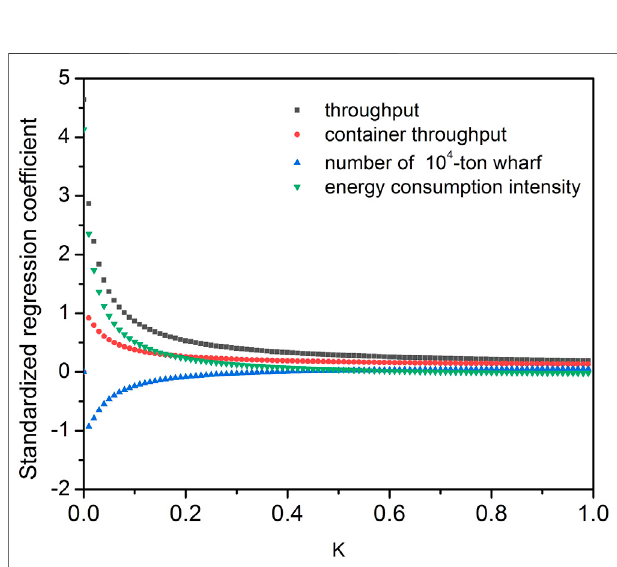
FIGURE 1 | Ridge trace fi gure.